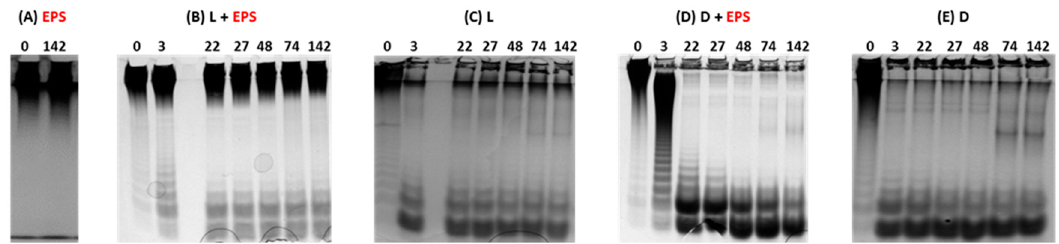
Figure 2. PAGE analysis of the native HMW GY785 EPS, EPS ( A ), EPS incubated with soluble cell lysate, L + EPS ( B ), soluble cell lysate, L ( C ), EPS incubated with insoluble cell debris, D + EPS ( D ), insoluble cell debris, D ( E ) in Tris HCl buffer at different incubation times (0, 3, 22, 27, 48, 74 and 142 h).